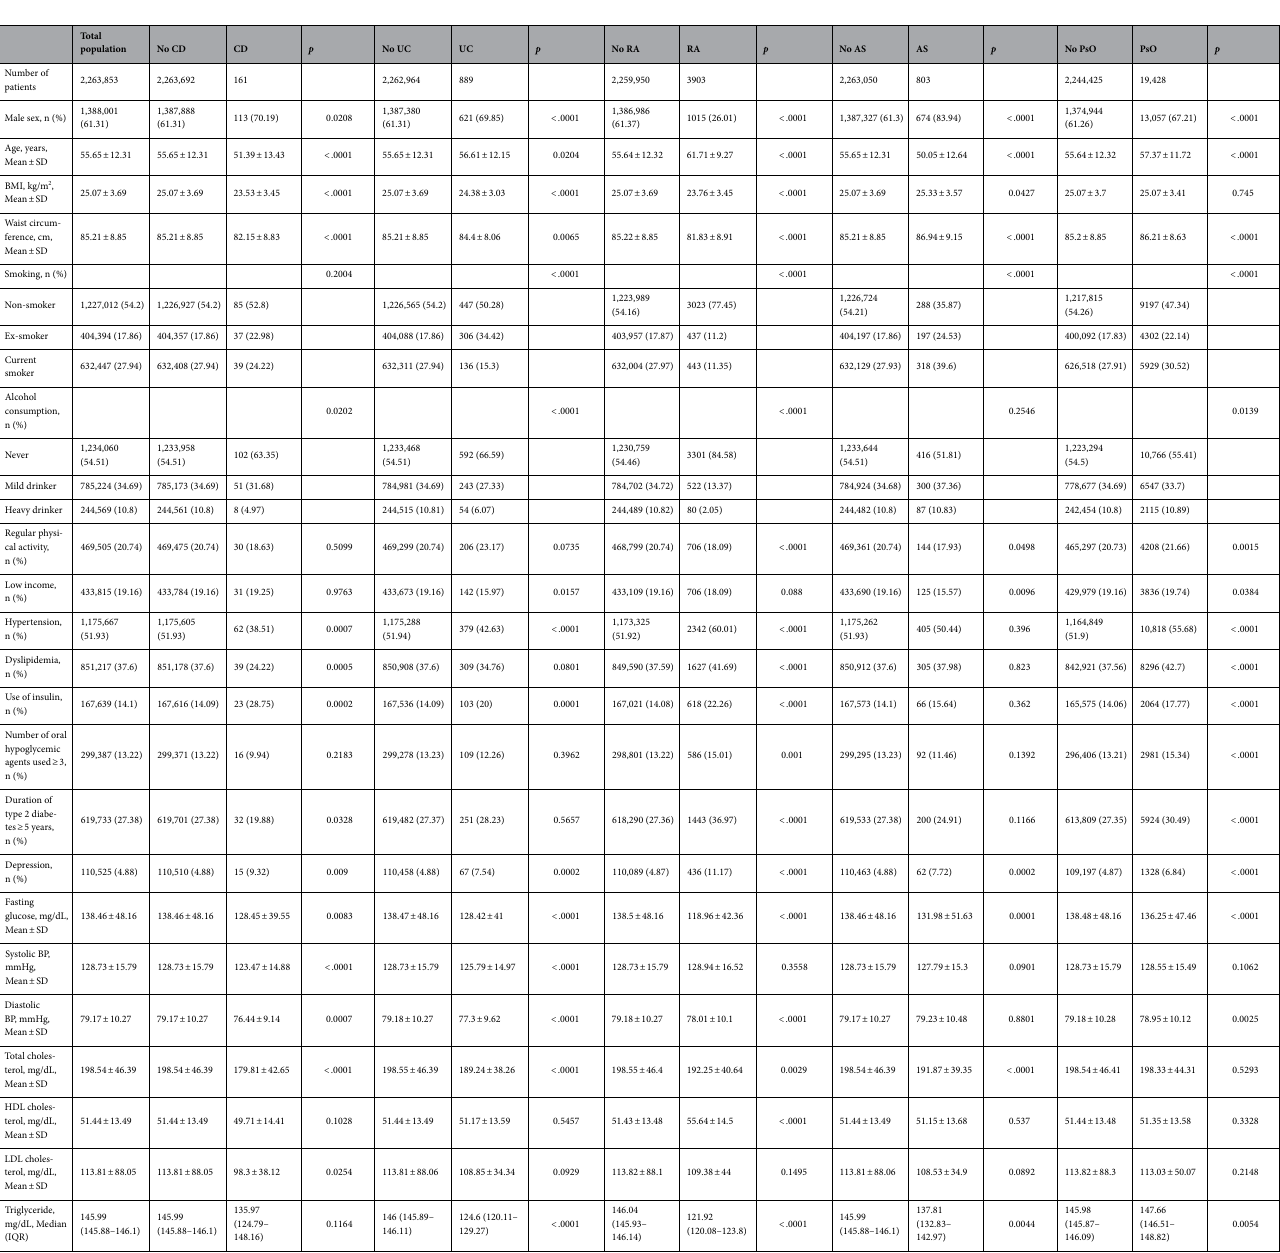
Table 1. Baseline characteristics of patients with type 2 diabetes according to the presence of immune- mediated inflammatory diseases. CD crohn’s disease, UC ulcerative colitis, RA rheumatoid arthritis, AS ankylosing spondylitis, PsO psoriasis, BMI body mass index, BP blood pressure, HDL high density lipoprotein, LDL low density lipoprotein, SD standard deviation, IQR interquartile